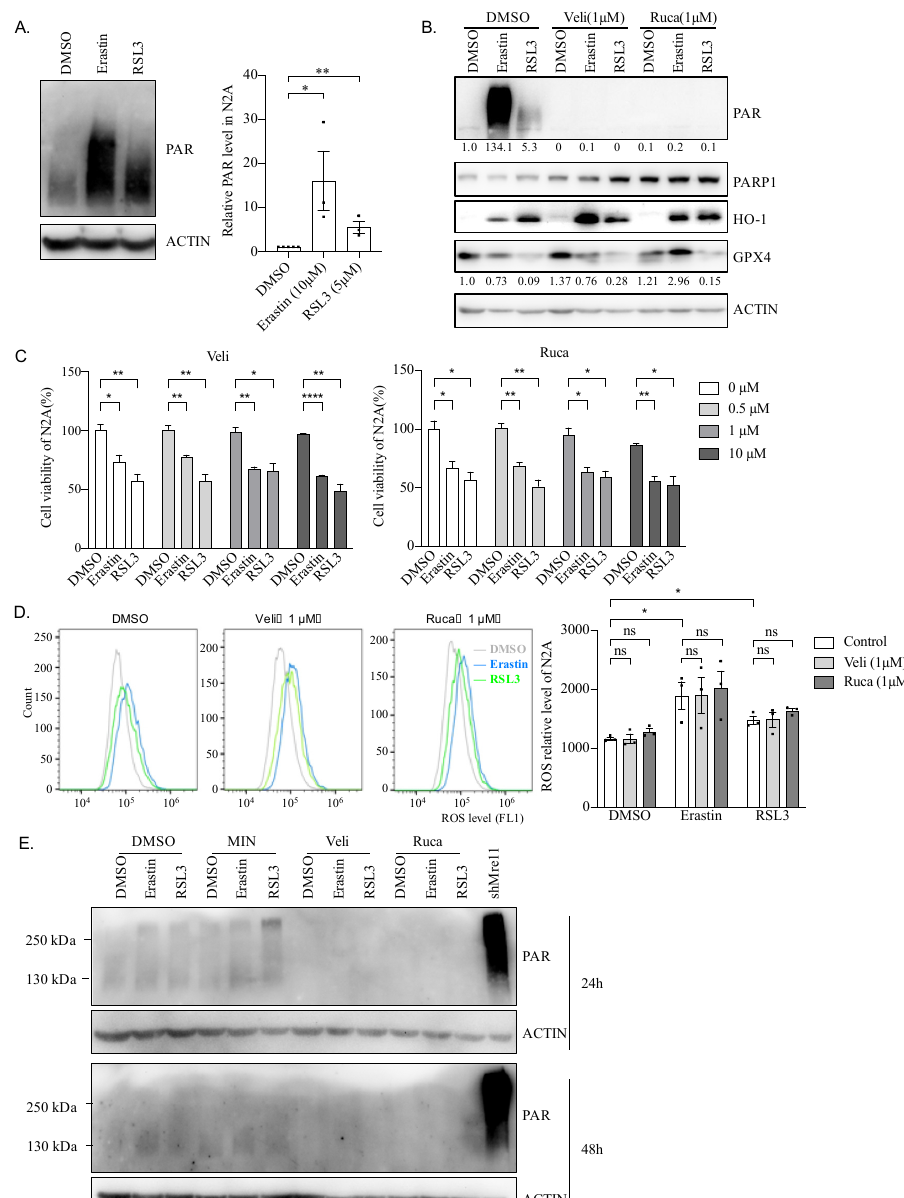
Figure 8. Erastin and RLS3 induce cell death independent of hyper PARP activity. ( A ) Erastin and RLS3 induce a high level of PAR in N2A for 24 h. Representative images of western blotting were shown on the left. Quantified relative expression of PAR to β -actin by Image J and the value was shown on the right. Data were obtained from three independent experiments. *: p < 0.05; **: p < 0.01. ( B ) Western blotting analysis of PAR, PARP, HO-1, and GPX4. N2A cell treated with DMSO, 10 µ M Erastin or 5 µ M RSL3 for 24 h, or combined with 1 µ M PARP inhibitor of veliparib (Veli) or rucaparib (Ruca) 2 h before with the indicated drugs. Protein extraction was prepared for Western Blotting analysis with indicated. Quantified relative expression of PAR or GPX4 to β -actin by Image J. Images represent three independent experiments. ( C ) Viability of N2A cells was measured after treating with indicated doses of PARP1 inhibitors Veli and Ruca together with ferroptosis inducers (10 µ M Erastin or 5 µ M RSL3) for 24 h. Data were obtained from three independent experiments. *: p < 0.05; **: p < 0.01; ****: p < 0.0001. ( D ) Lipid ROS level in N2A cells treated with indicated drugs for 24 h and detected by FACS. Data were obtained from three independent experiments. *: p < 0.05; ns: not significant. ( E ). Western blotting analysis of PAR in primary neurons. Neurons treated with DMSO, 50 µ M Erastin or 5 µ M RSL3 for 24 h (up) or 48 h (down). Neuron was also treated by a PARP inhibitor of 0.1 µ M MIN (minocycline), 1 µ M Veli or 1 µ M Ruca for 12 h before being treated with ferroptosis inducers. Protein extraction was prepared for Western Blotting analysis with indicated. The last lane of sh Mre11 was used as a positive control for